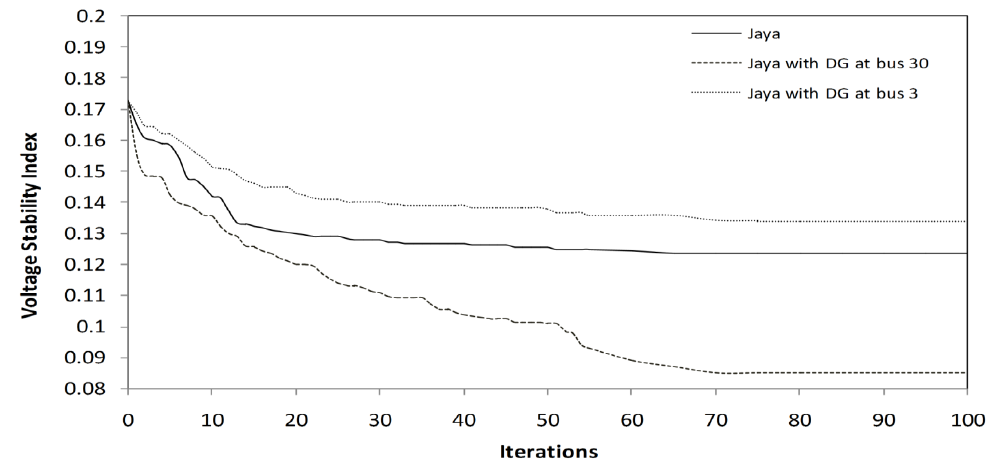
Figure 6. Convergence of Jaya method for case 3. Table 4. Comparison of the results obtained for voltage stability enhancement (modified IEEE 30-bus network).